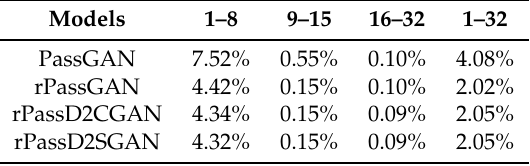
Figure 7. N-gram JSD of generated password dictionary ( X -axis: password length; Y -axis: JSD value). Table 1. Redundancy rate of password guessing candidate dictionary.